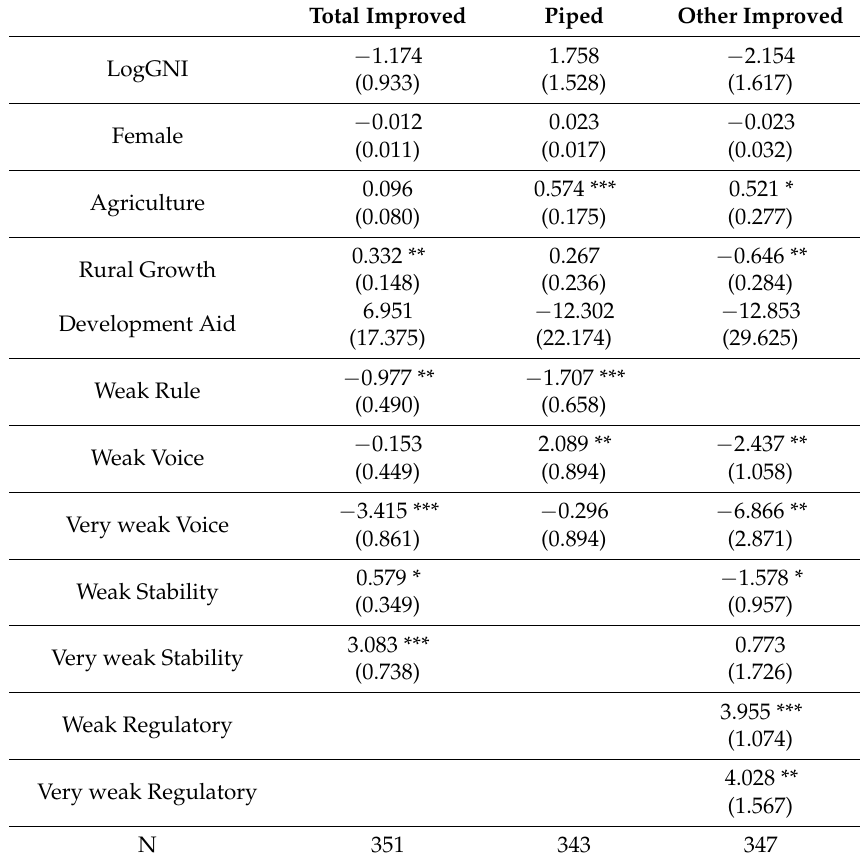
Table 5. Socioeconomic indicators. Middle-high income